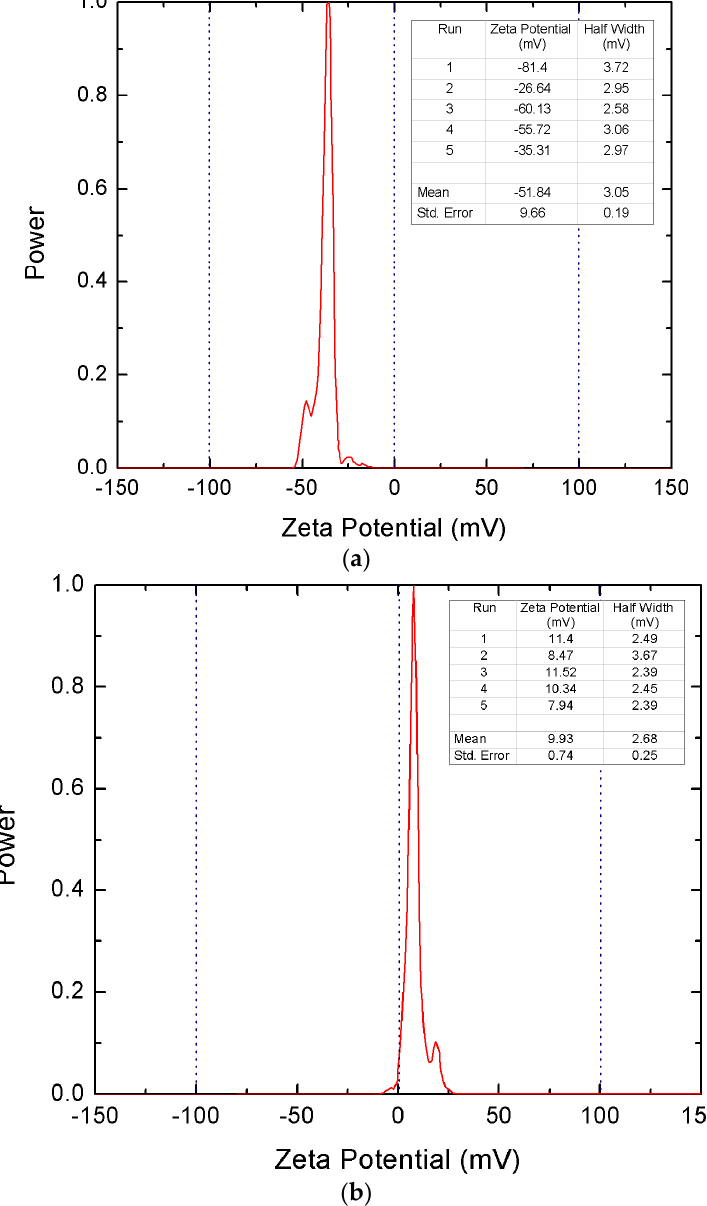
Figure 5. ( a )Zeta potential result for fCNTs, showing a peak at − 35.31 mV in the fifth run with a mean of − 51.84 mV and a standard deviation of 9.66 mV; ( b ) zeta potential result for TiO 2 –fCNTs, showing a peak at 7.94 mV in the fifth run with a mean of − 9.93 mV and a standard deviation of 0.74